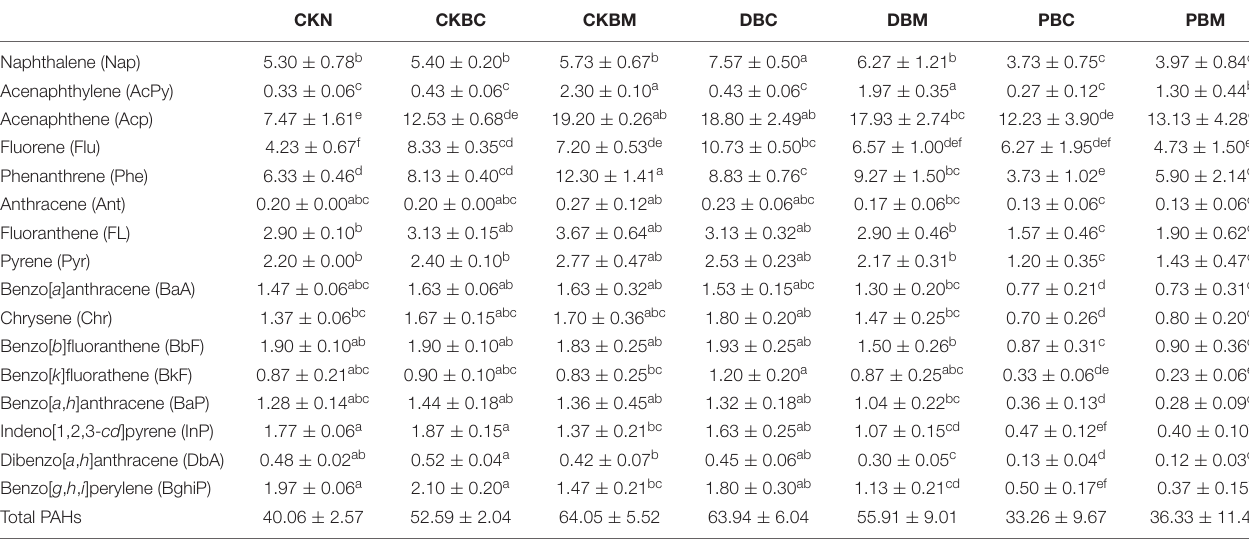
Different letters after the same column of numbers indicate that there was significant difference between different treatment groups under the same particle size (p < 0.05), the same as in the succeeding tables. PAH, polycyclic aromatic hydrocarbon.